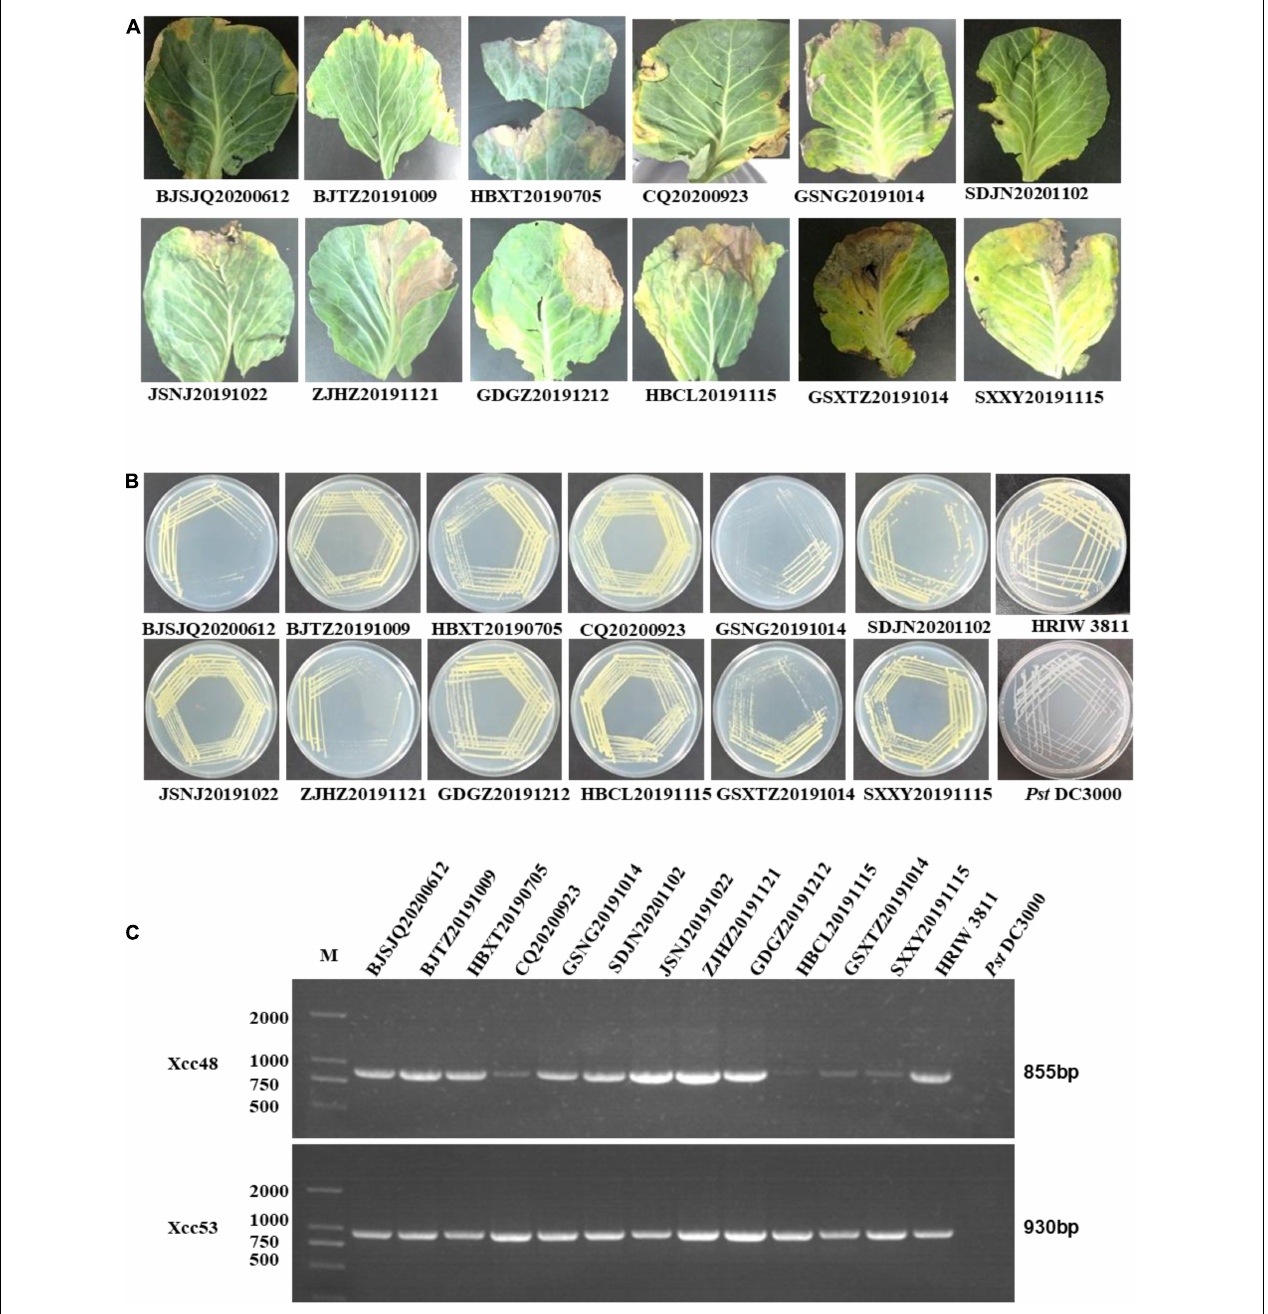
FIGURE 1 | Purified colony morphology isolated from diseased cabbage leaf samples and specific molecular detection of Xcc in cabbage. (A) Diseased leaves collected in different cabbage growing regions of China. (B) Purified strain colonies growing on LB medium. (C) Detection of the isolated strains by Xcc -specific markers, where Xcc_48F/R and Xcc_53F/R were used to distinguish Xcc strains from other bacterial species. Isolated strains: BJTZ20191009 and BJSJQ20200612, CQ20200923, HBXT20190705 and HBCL20191115, SXXY20191115, GSXT20191014 and GSNG20191014, JSNJ20191022, GDGZ20191212, ZJHZ20191121 and SDJN20201102 were collected from Beijing, Chongqing, Hebei, Shaanxi, Gansu, Jiangsu, Guangdong, Zhejiang, and Shandong provinces in China. HRIW 3811 and Pseudomonas syringae pv. tomato DC3000 were used as the positive and negative control, respectively.